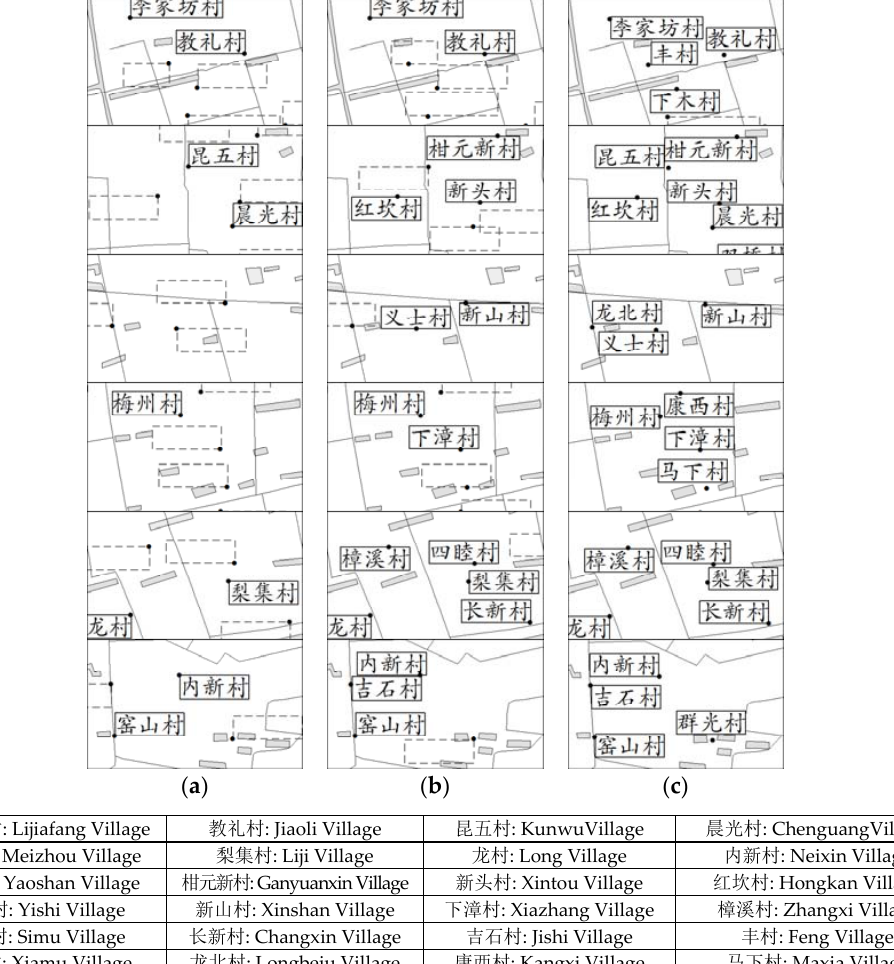
Figure 14. Detailed comparisons within the rectangular regions for the RoadResident instance. The Chinese words are the geographic names to be labeled with no conflict. ( a ) Four-position model; ( b ) four-slider model; ( c ) the proposed model.